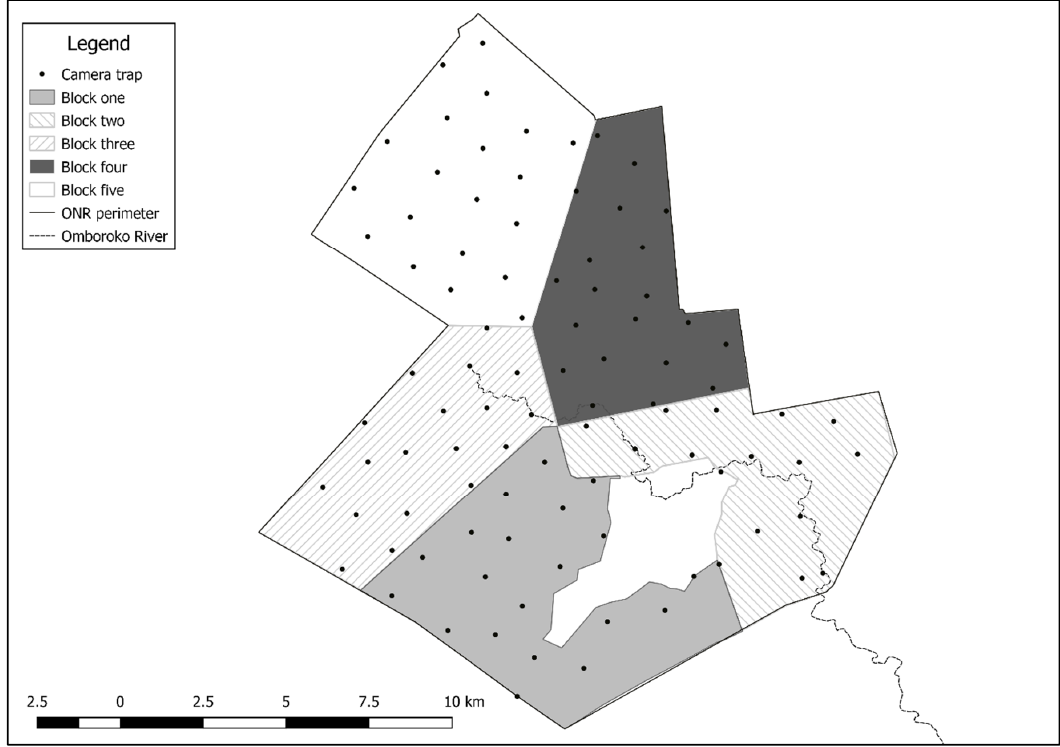
Figure 1. Division of the study area in five blocks and camera trap placement used for leopard density estimation in Okonjima Nature Reserve (ONR).